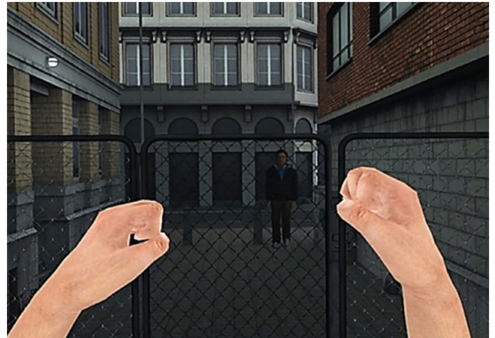
Figure 3. Virtual representation of the participants’